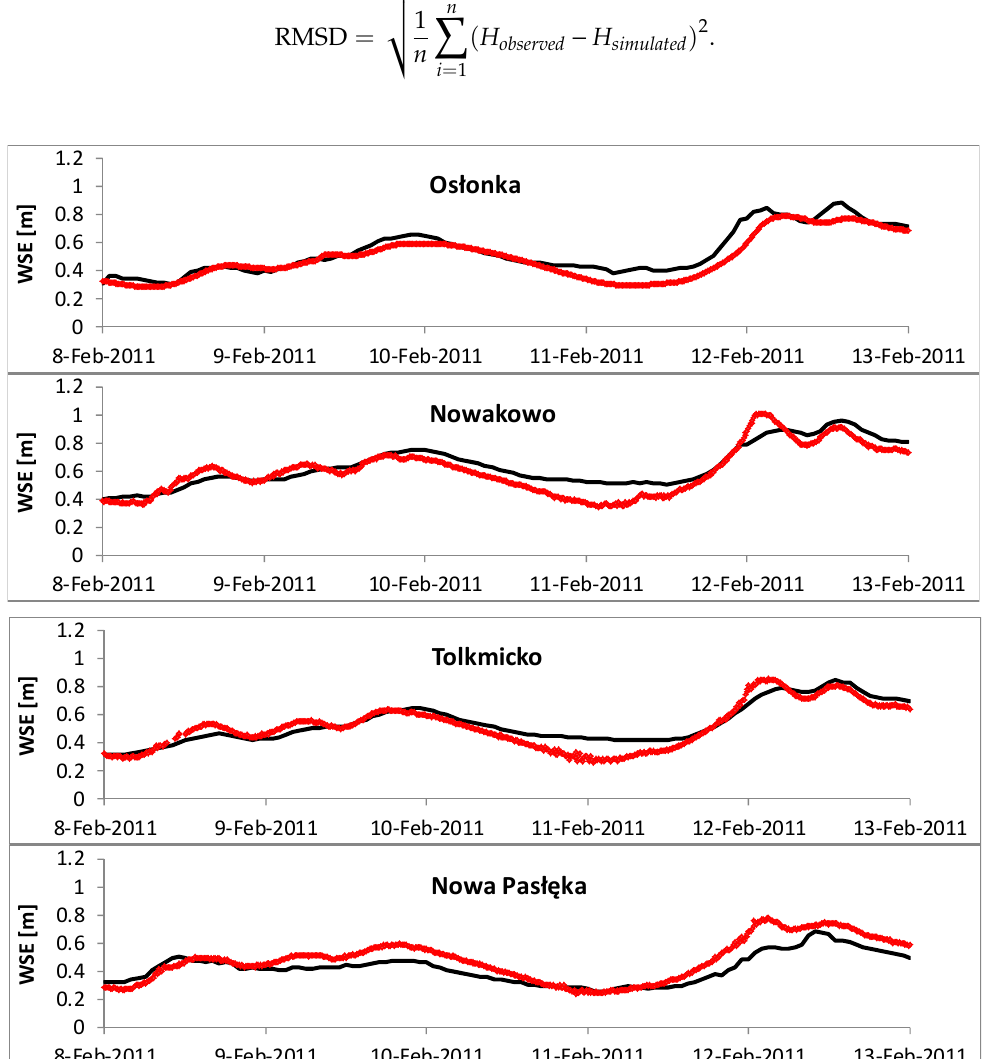
Figure 7. Measured (red dots) and simulated (black line) WSE in February 2011, at locations along the South Polish shore of the Vistula Lagoon.